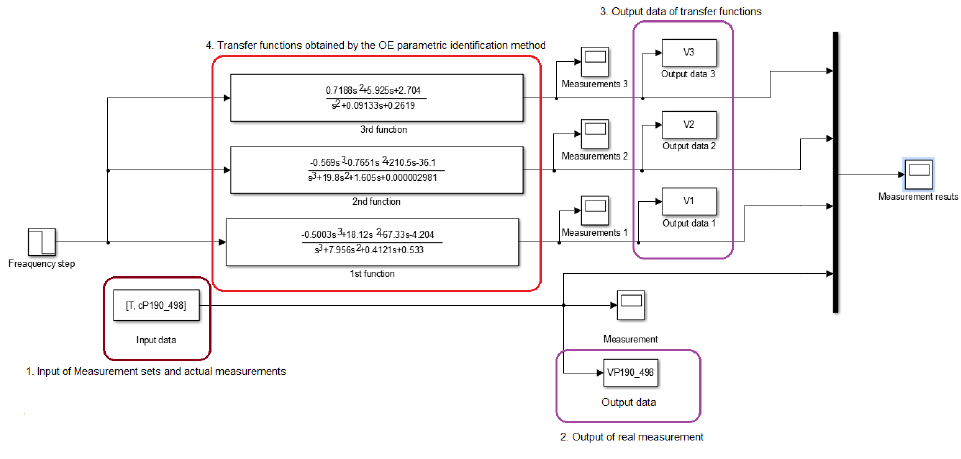
Figure 5. Research model developed in the Simulink environment.